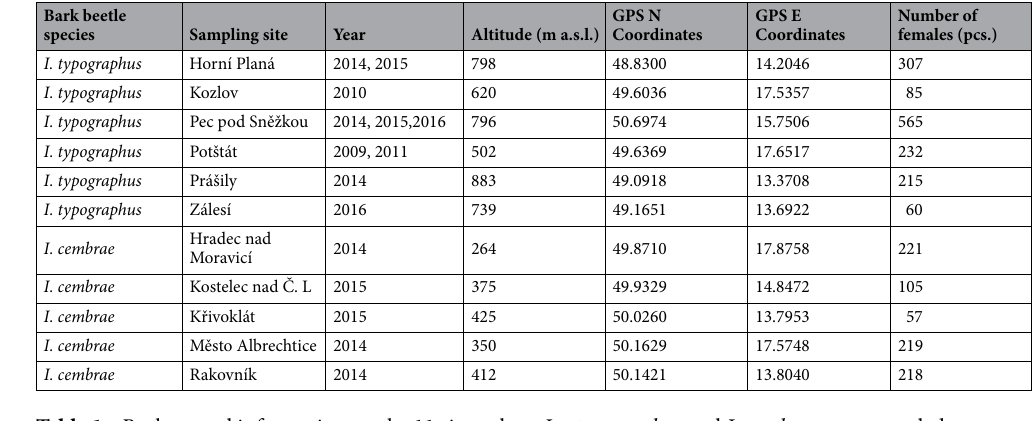
Table 1. Background information on the 11 sites where Ips typographus and I. cembrae were